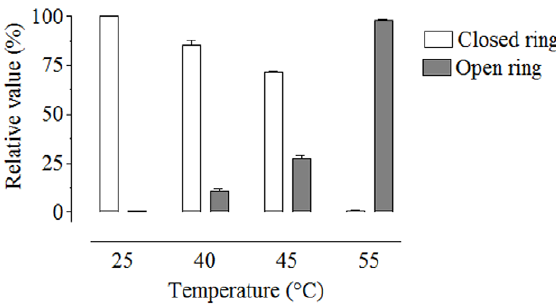
Figure 3. Effect of temperature on the opening of the epoxide ring of JH III. JH III was incubated with sodium sulphide (100 mM) at different temperatures. White bars indicate the percentage of intact JH III after the reaction and dark bars indicate JH III with open rings after the reaction. Data represent the means 6 SD of three independent experiments.